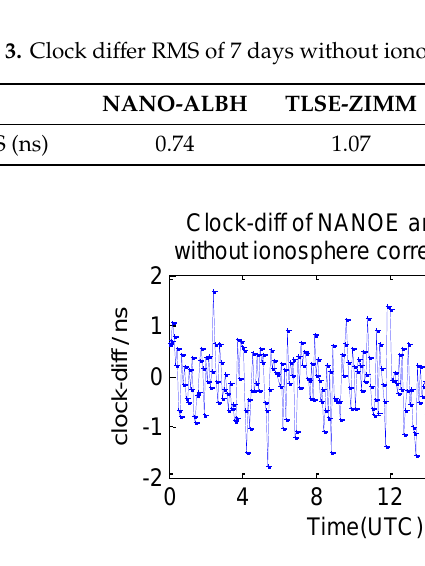
Figure 9. Clock difference between NANO and ALBH (without ionosphere correction).